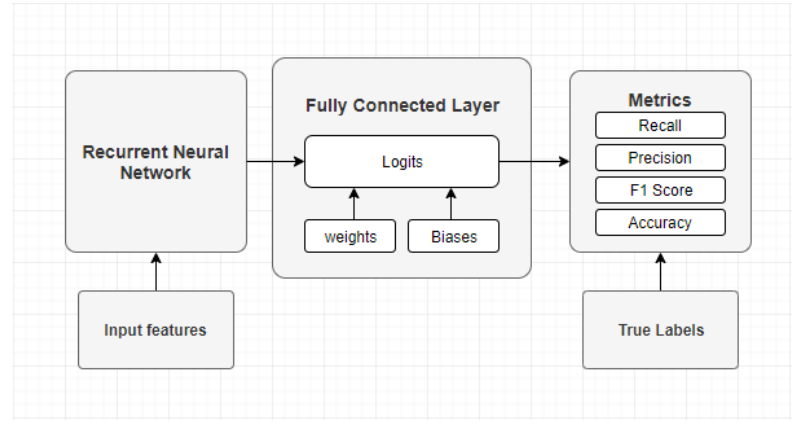
Figure 6. Structure of the Recurrent Neural Network